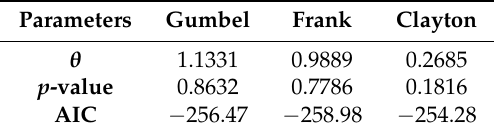
Table 7. Different Archimedean Copula Function parameters and the fitting test